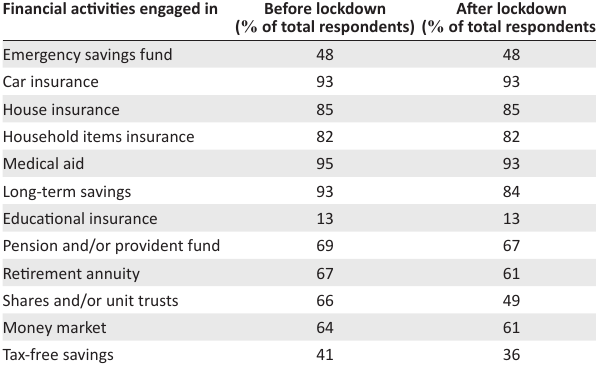
TABLE 6: Financial activities for unforeseen circumstances.